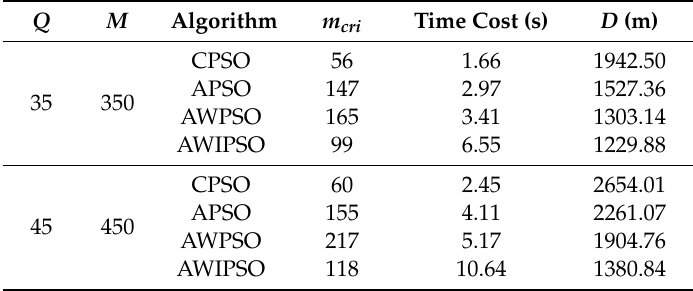
Table 5. Simulation results of each algorithm with two numbers of planned